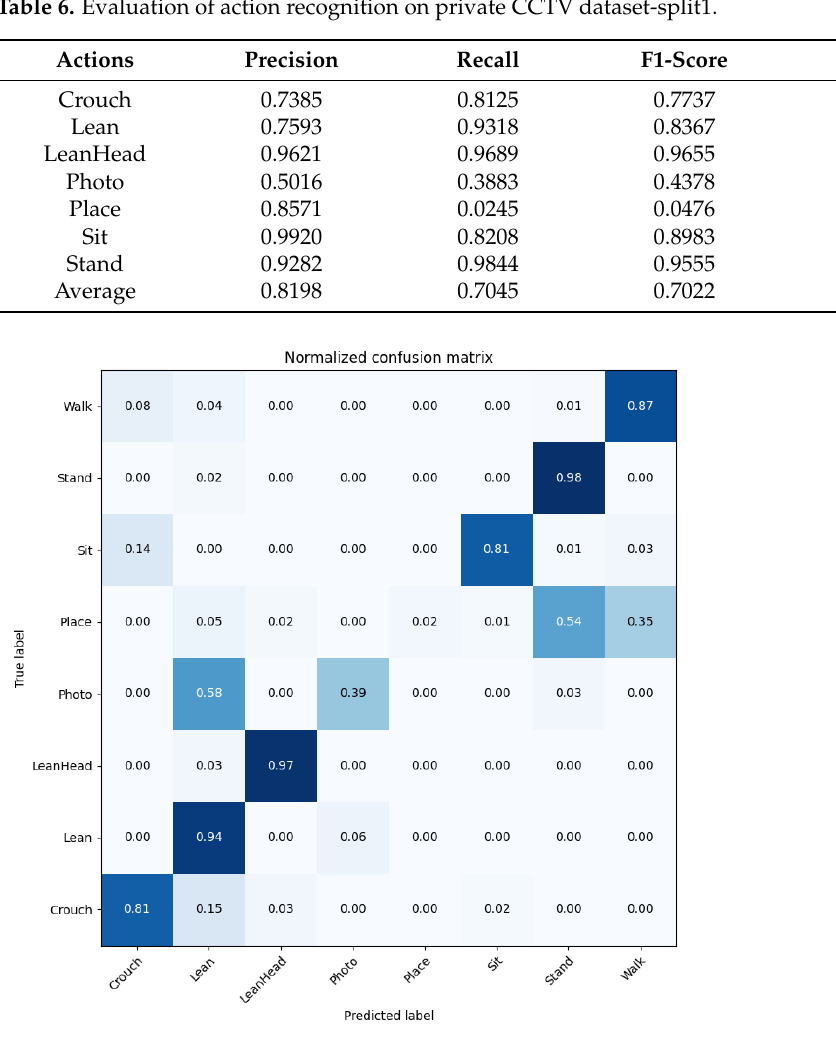
Figure 8. Confusion matrix of action recognition task on CCTV dataset-split1 obtained by the proposed pipeline, with darker color indicates higher